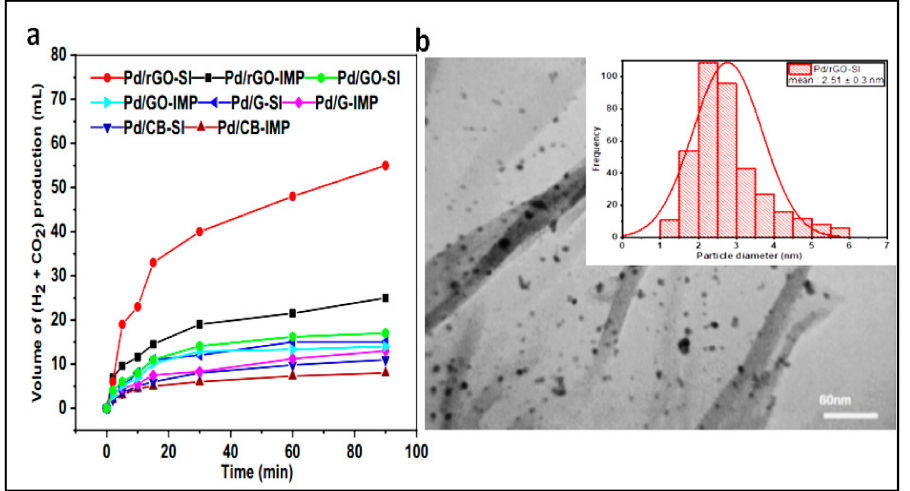
Figure 4. Formic acid decomposition over nanoheterogeneous Pd prepared by different methods, and TEM image: ( a ) Volume of generated gas (H 2 + CO 2 ) Reaction conditions: 0.12 mg of catalyst, 30 ◦ C, 0.5 M FA, (substrate/metal molar ratio 2000:1), 800 rpm and 90 min reaction time. ( b ) TEM images and insert figure show distribution of particle size in Pd/rGO-SI. Reprinted with permission from ref. [79]. Copyright 2021 Springer